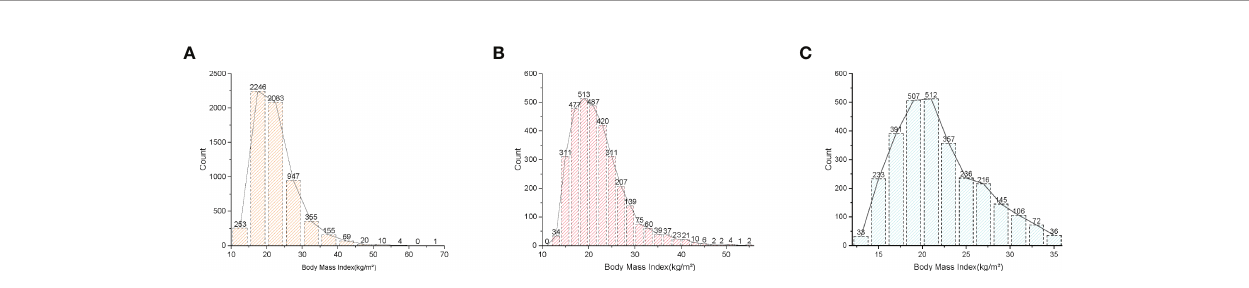
FIGURE 2 | Distribution histogram of BMI. (A) Among all participants. (B) Among all males. (C) Among all females. Body Mass Index,